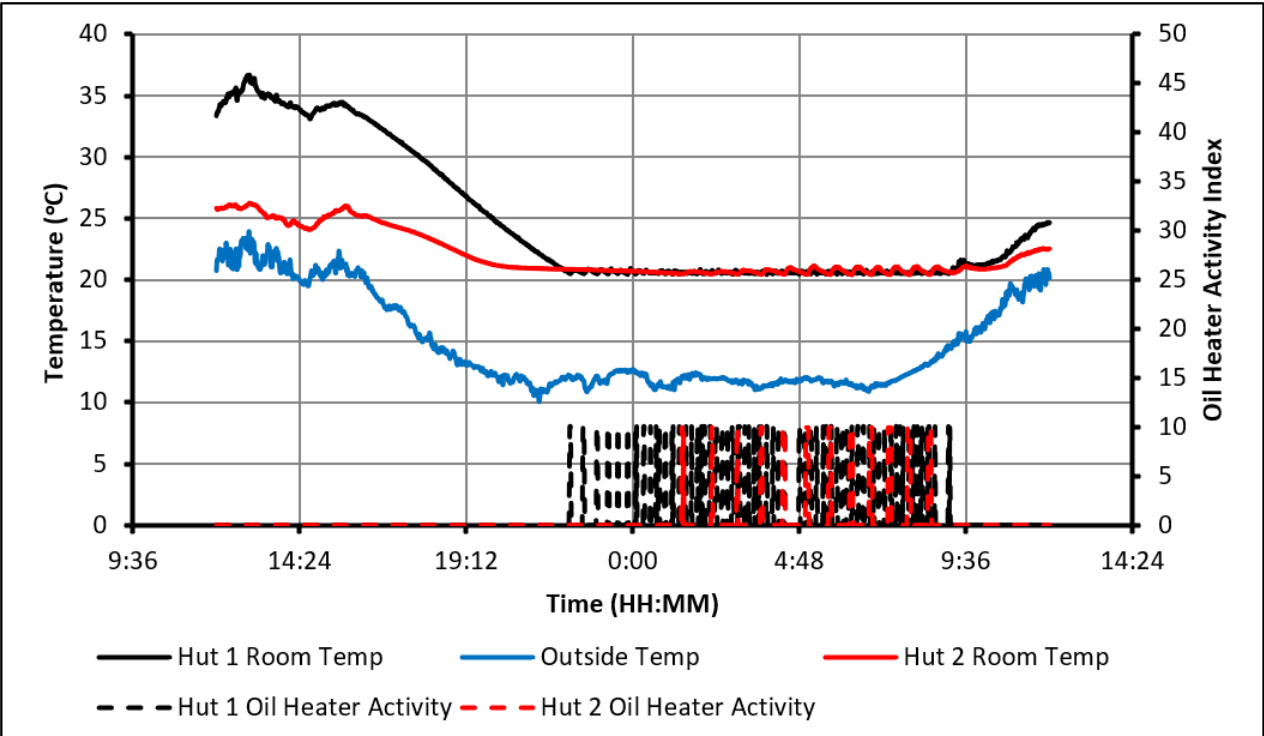
Figure 7. Temperature profiles of the huts and solar air heater (20 – 22 °C temp constraints, day 6).